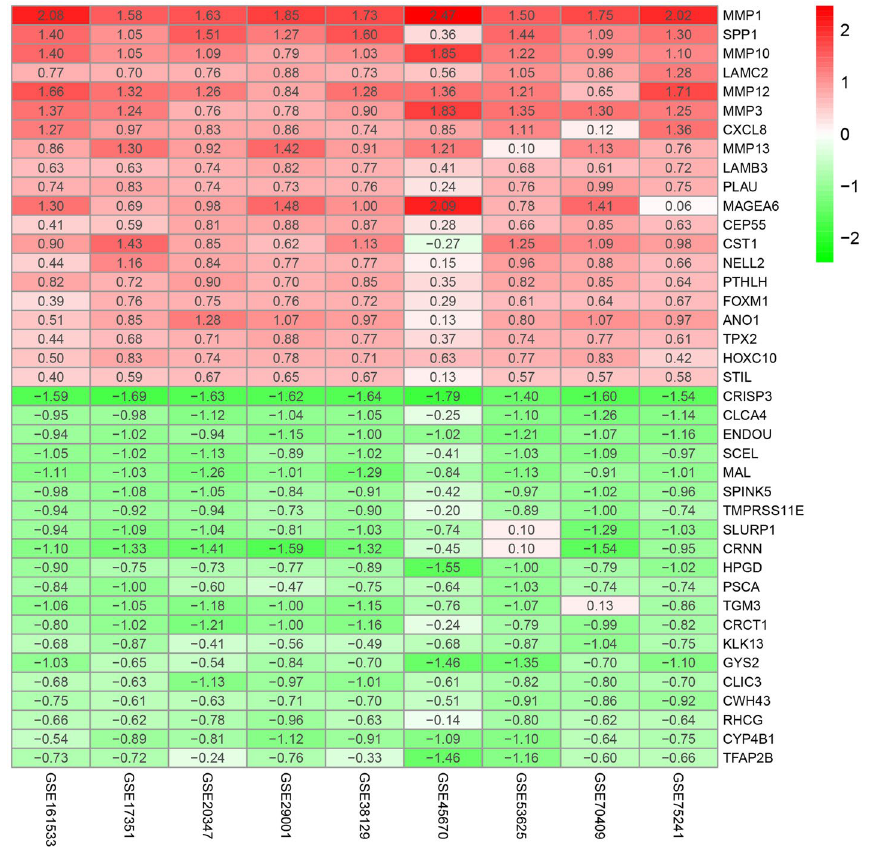
Figure 2. Top 20 robust DEGs in ESCC vs. normal tissues. Heatmap of the top 20 upregulated and downregulated robust DEGs identified by the RRA algorithm. Red indicates robust DEGs with high expression, while green indicates robust DEGs with low expression. The heatmap was drawn using R software (version 3.6.3, https:// www.r- proje ct. org/). DEGs, differentially expressed genes; RRA, robust rank